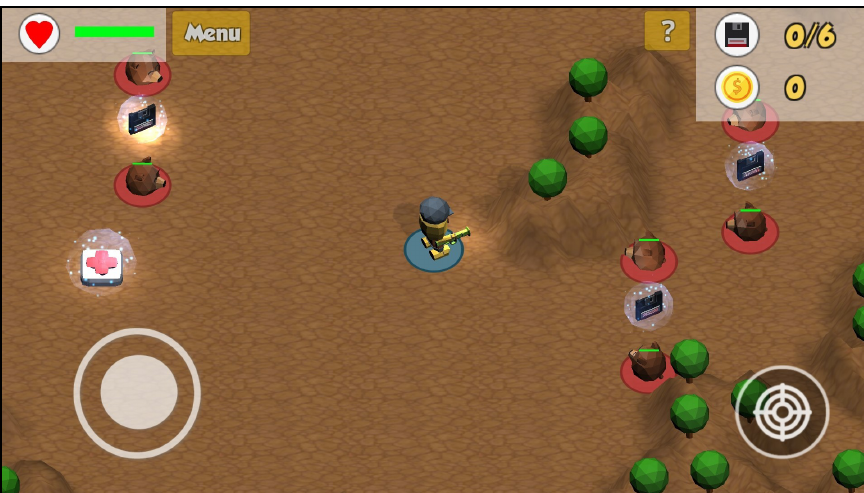
Fig. 2. Player has to collect disks in the explorative gaming